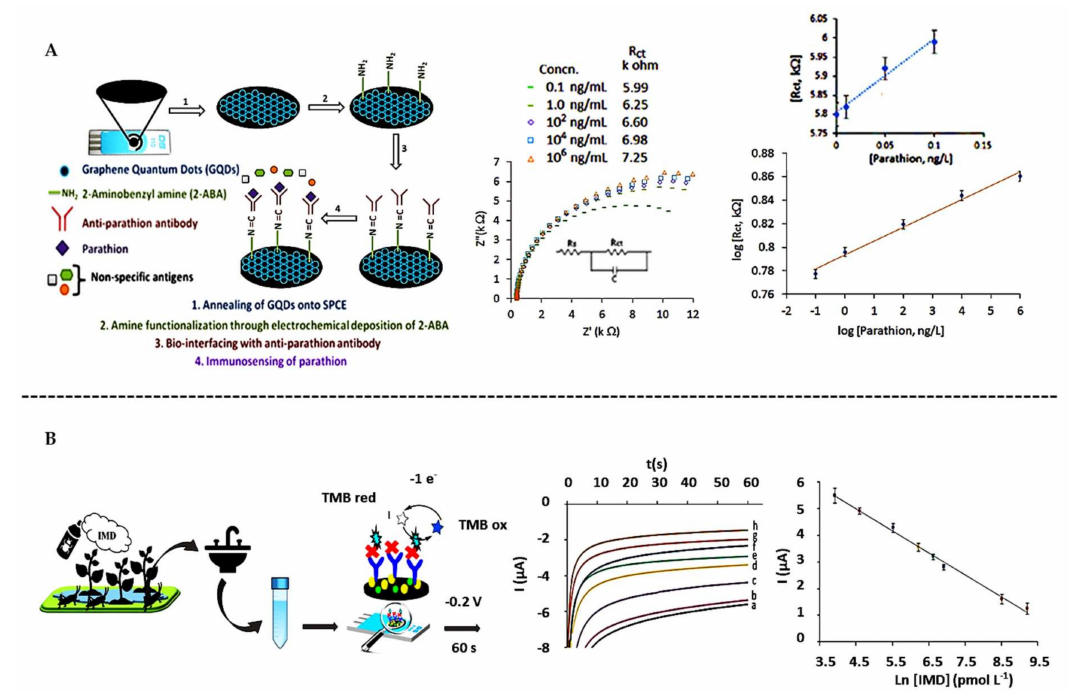
Figure 6. Immunosensors for the determination of pesticides on screen-printed electrodes. ( A ) Use of GQDs to determine Parathion, Niquist curves and calibration curve. Reprinted from [177], Copyright 2017, with permission from Elsevier. ( B ) Direct competitive immunosensor using AuNPs for the determination of Imidacoprid (IMD), chronoamperometroc measurements and calibration curve. Reprinted from [180], Copyright 2020, with permission from